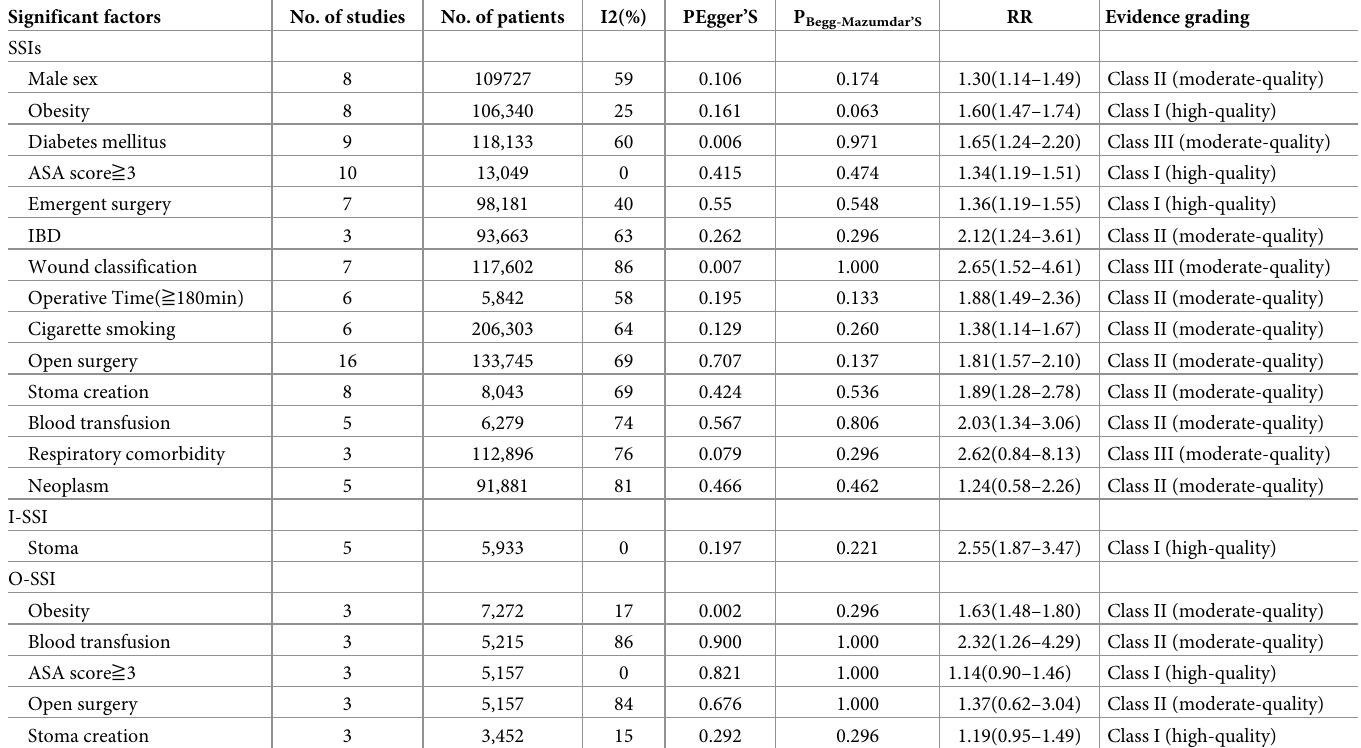
Table 2. Risk factors of SSIs, I-SSI, and O-SSI in patients undergoing